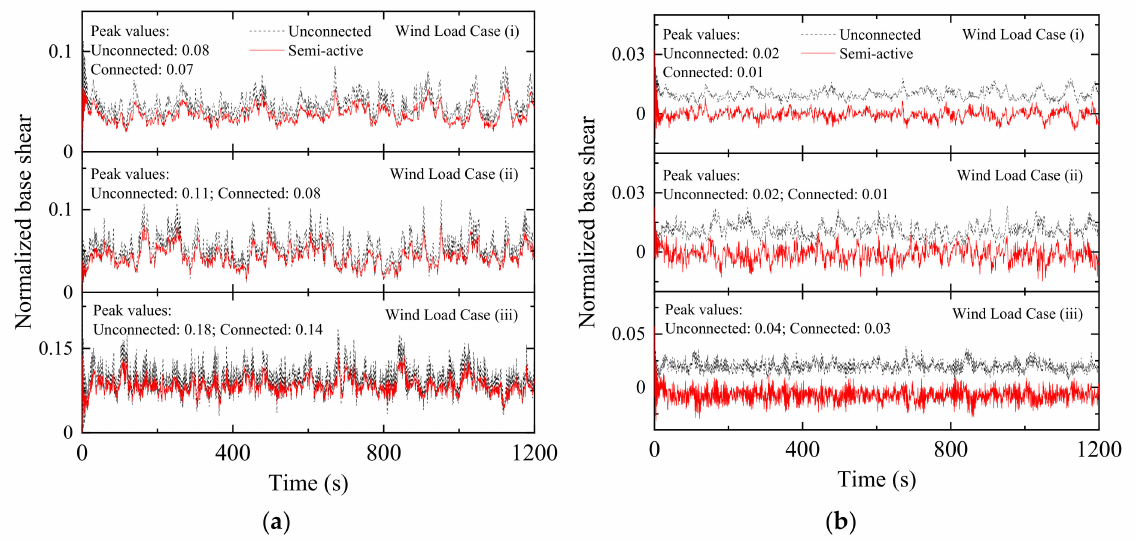
Figure 25. Time history of normalized base shear under wind excitation in: ( a ) a building on the upwind side and ( b ) a building on the downwind side when flexible adjacent buildings are connected using semi-active MR dampers following damper Configuration